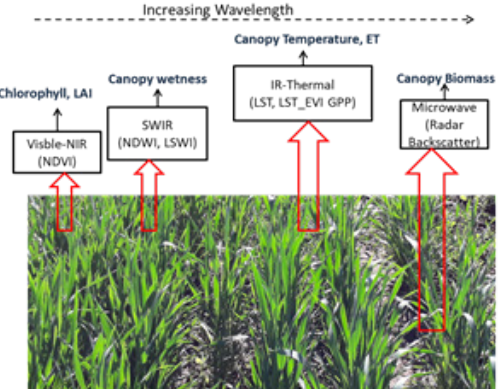
Fig. 1. Indices used in different parts of Electromagnetic spectrum and influencing wheat crop parameters